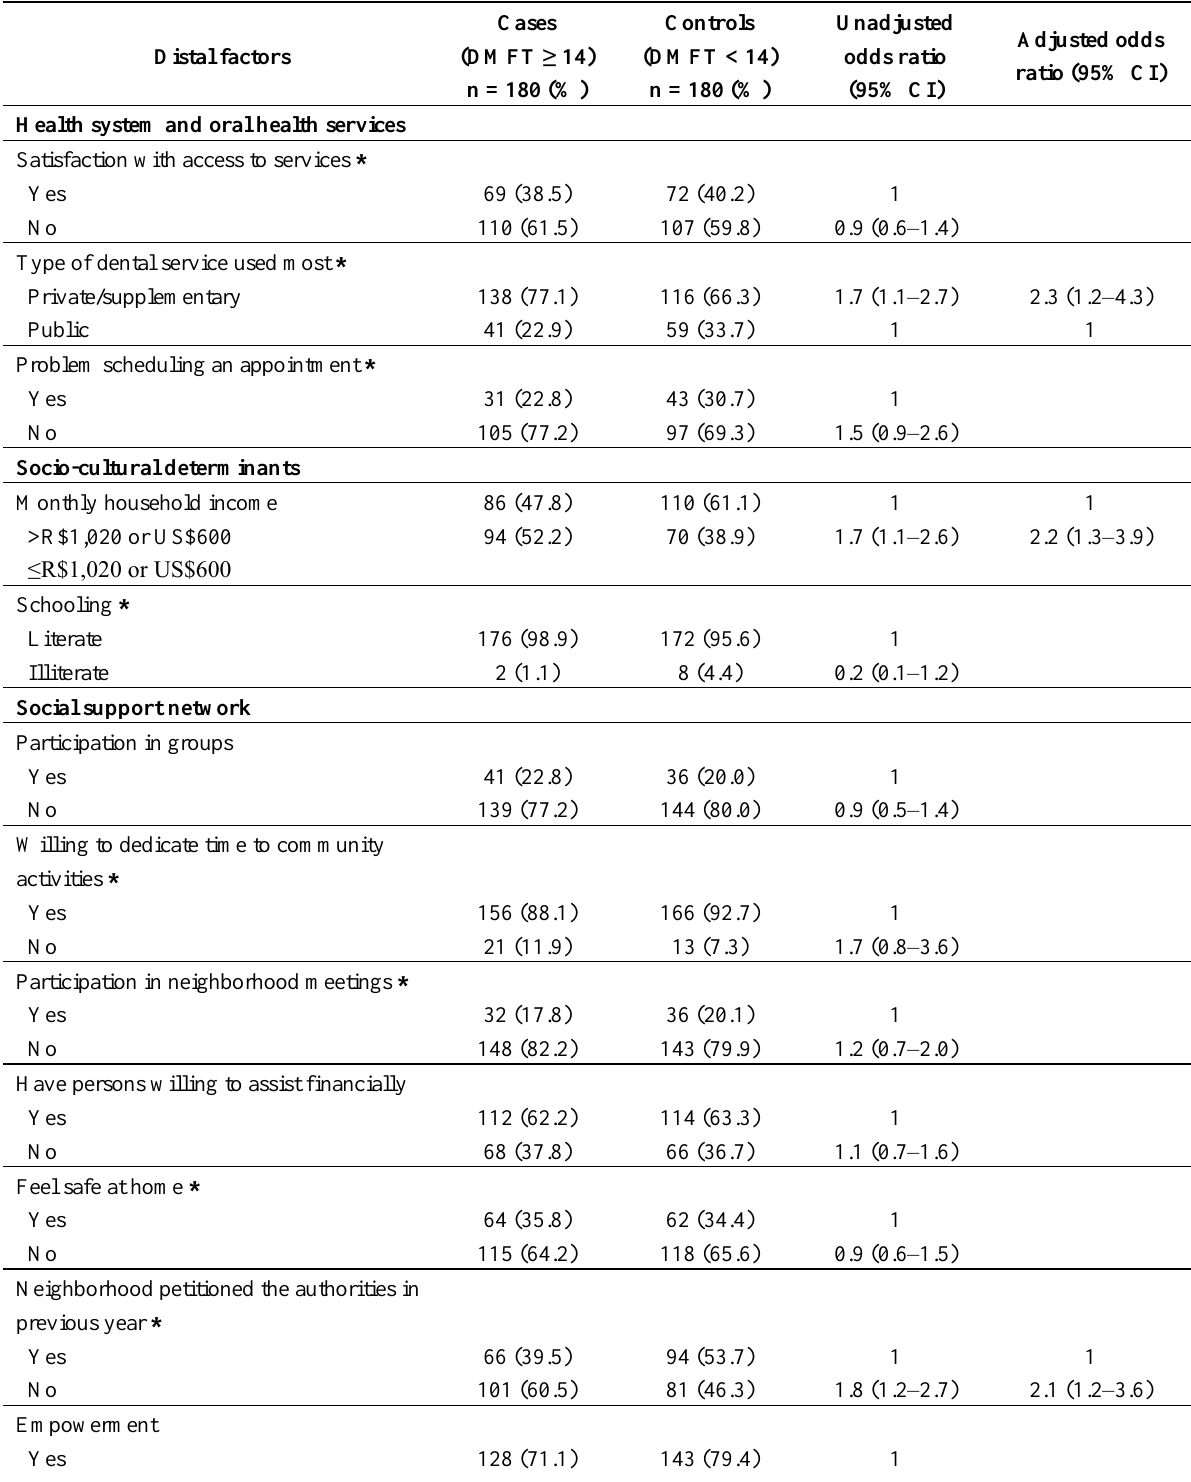
Table 1. Distal factors associated with high dental caries in adults, Brazil, 2010. Distal